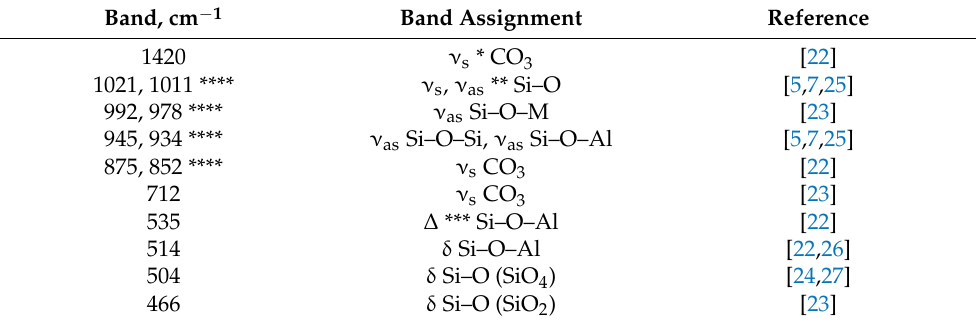
Table 5. Assignment of spectrum bands to components of the chemical composition of granulated blast furnace